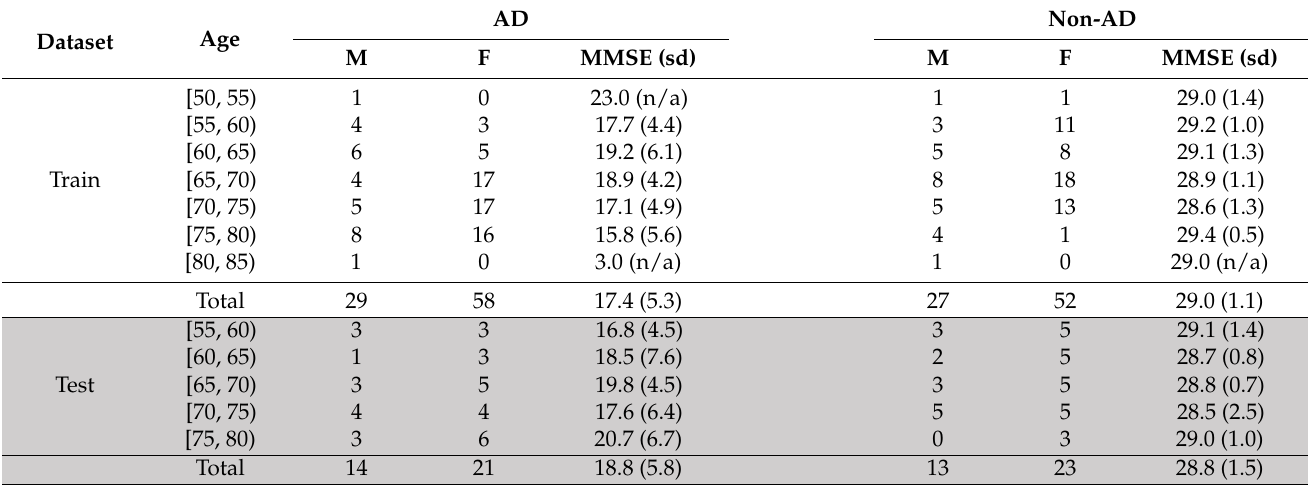
Table 1. Basic characteristics of the subjects in ADReSSo training and testing (shaded) datasets (M = male. F = female). n/a: not applicable.